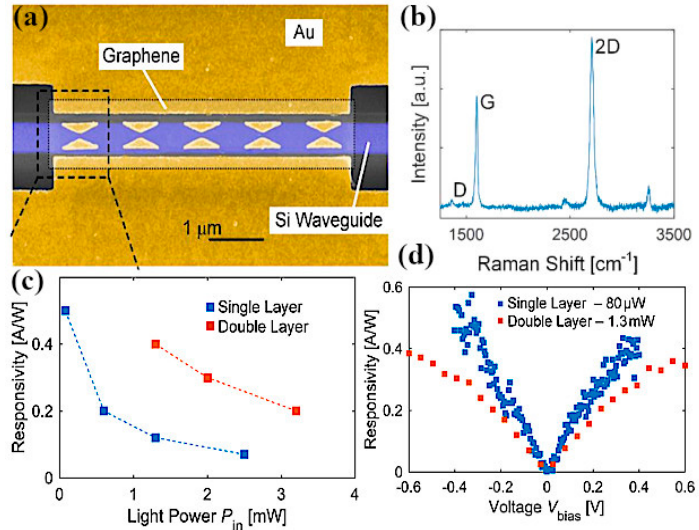
Figure 19. ( a ) Schematic of a waveguide graphene antenna integrated photodetector, where a long strip of graphene is placed beneath the bowtie antenna; ( b ) Raman spectroscopic measurement of a monolayer graphene photodetector; ( c ) Responsivity of the photodetector with respect to light intensity; ( d ) Photoresponse versus voltage of single- and bi-layer graphene detectors, where the double-layer detector has more responsivity than the single-layer photodetector. © 2018 ACS, Reprinted with permission from [277].